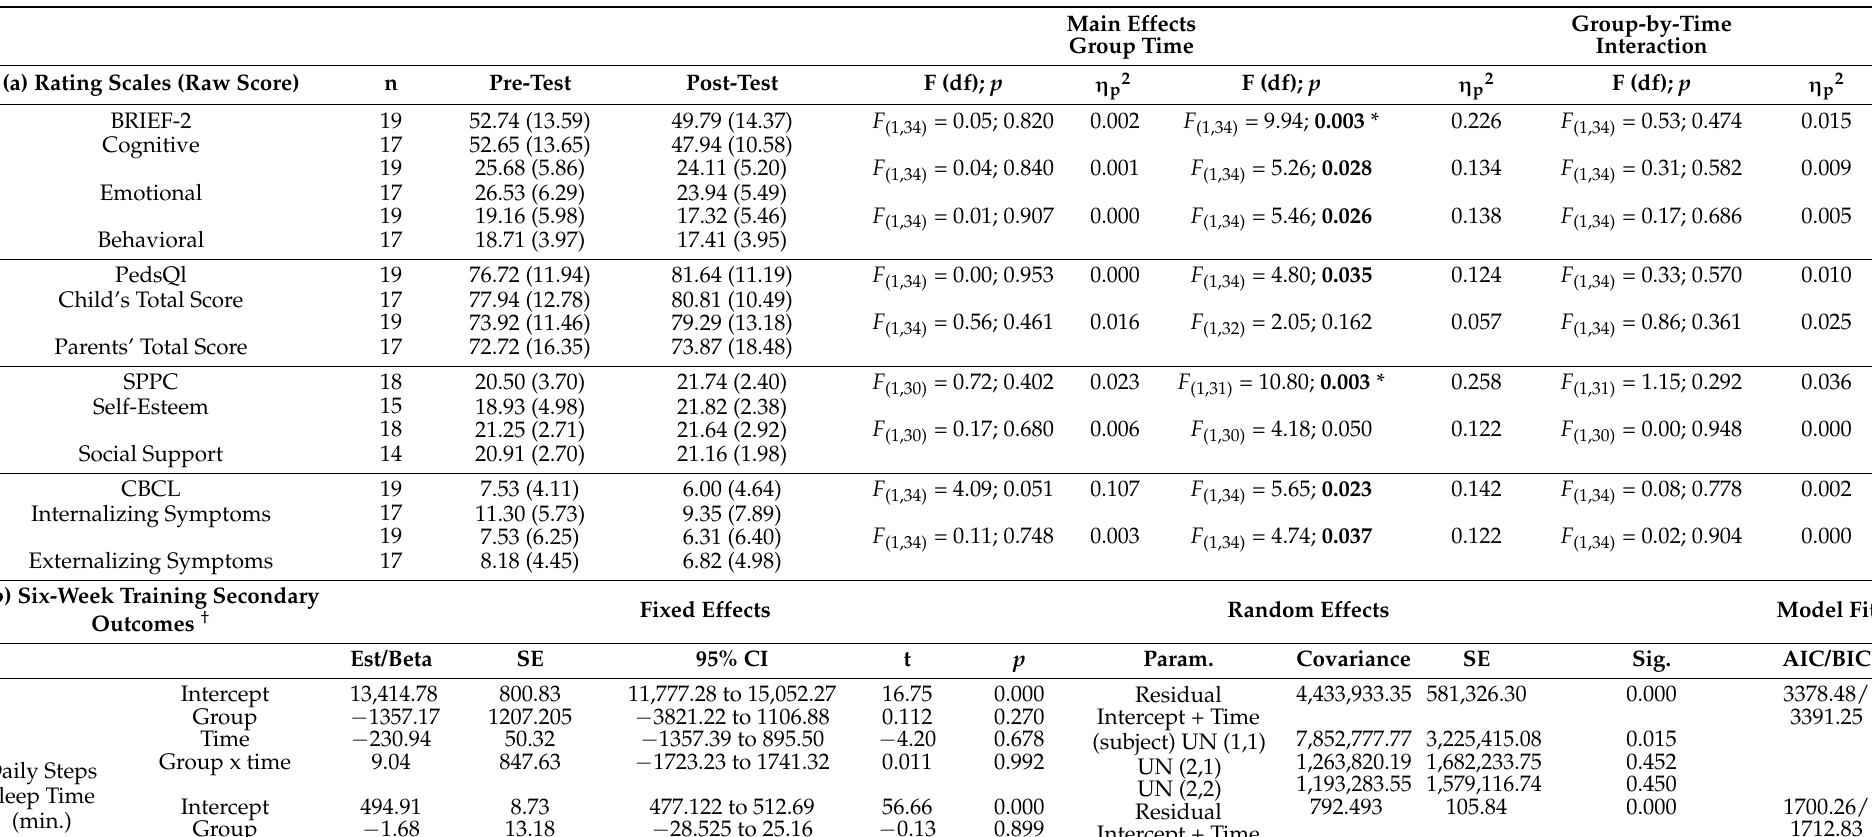
Table 4. EF training effects on secondary outcomes: (a) post hoc analyses of rating scales and (b) evolution of healthy habits across the 6-week training period.